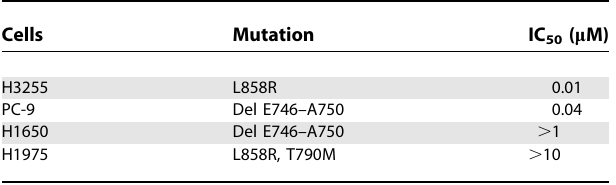
Table 1. Sensitivity of EGFR- Mutant Lung Adenocarcinoma Cell Lines to